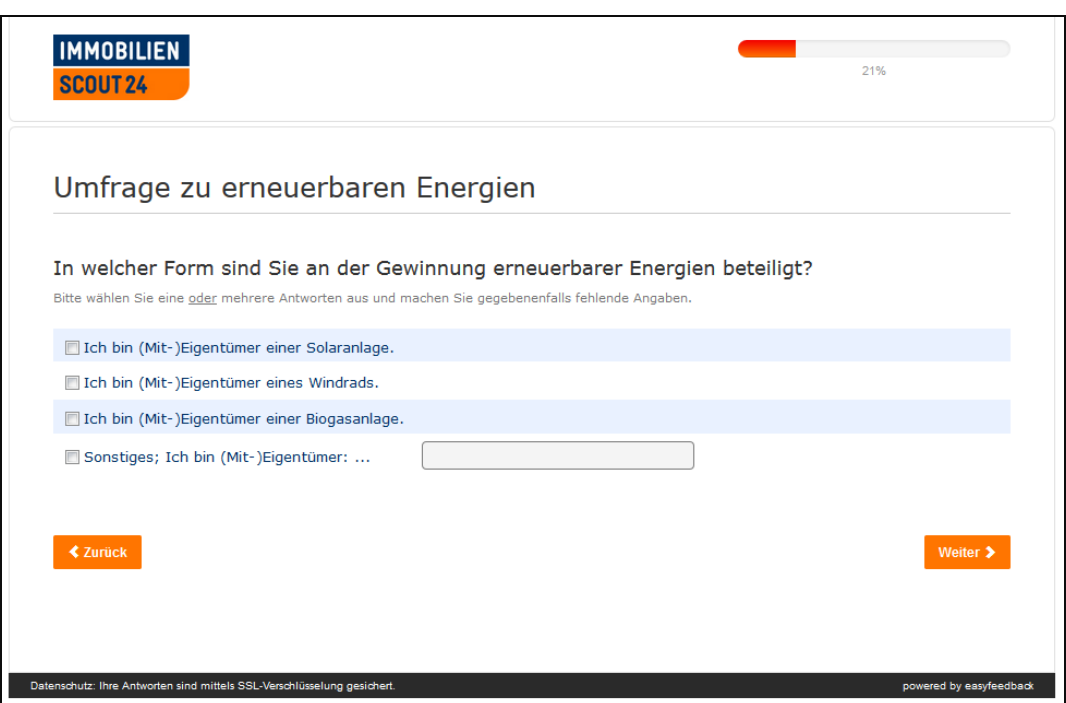
Figure A6. Screenshot of Questionnaire Page 5.